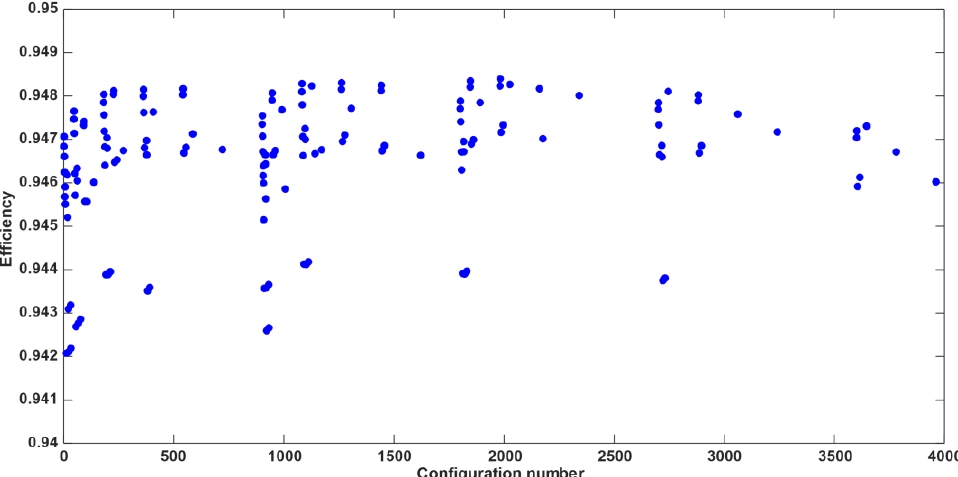
Figure 8. Values of efficiency for the 154 selected configurations.